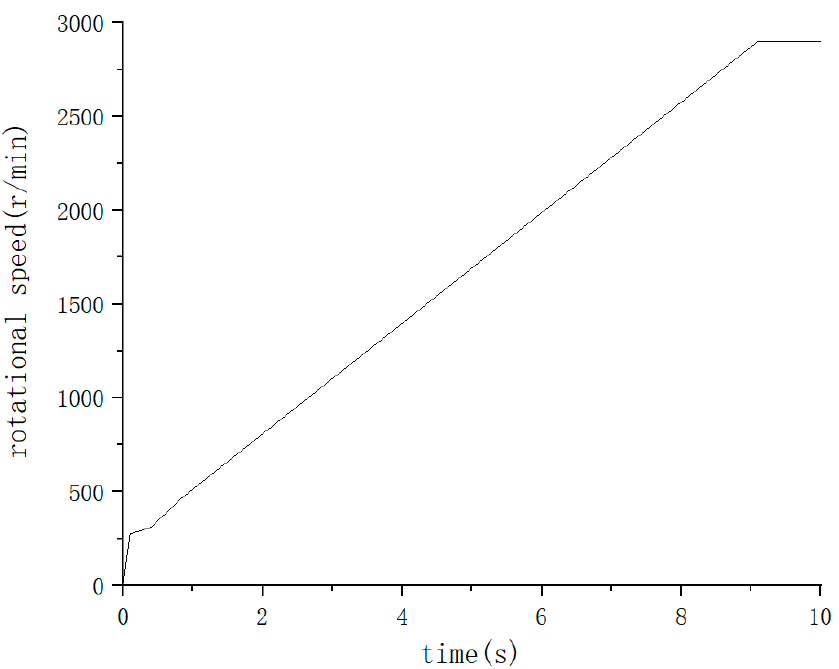
Figure 6. The rotational speed of pump measured by the photoelectric speed sensor.